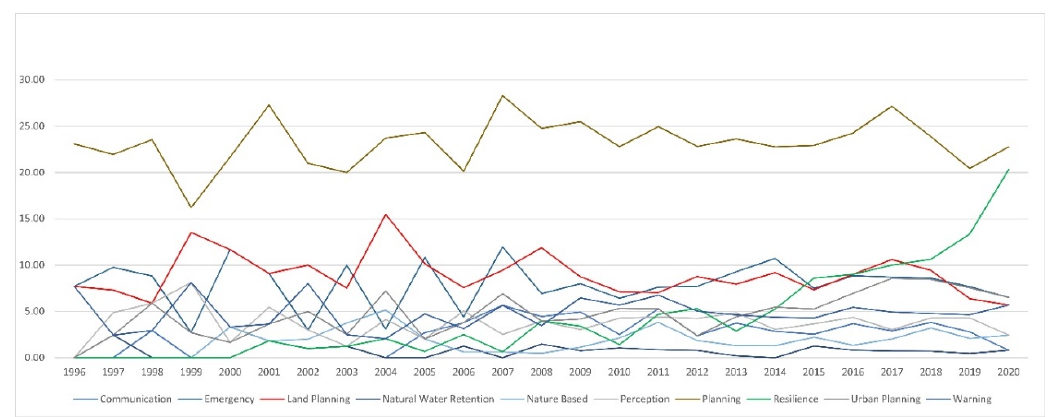
Figure 10. Temporal evolution (1996–2020) of the percentage of FRAs references in WoS databases related to each field of application versus the total of FRAs publications in each year.